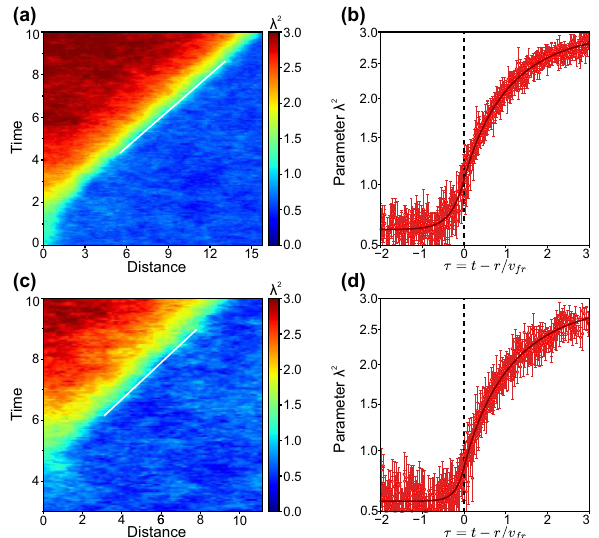
Figure 6. Self-similar fronts during the growth of supercritical and spontaneously-formed nucleus: Evolution of (cid:31) 2 -field in radial directions shown with white arrows in Fig. 5(b2, c2) for ( a , b ) supercritical and ( c , d ) spontaneously-formed nucleus. ( a , c ) and ( b , d ) are obtained in the same manner as ( d , e ) in Figs. 2 and 3.